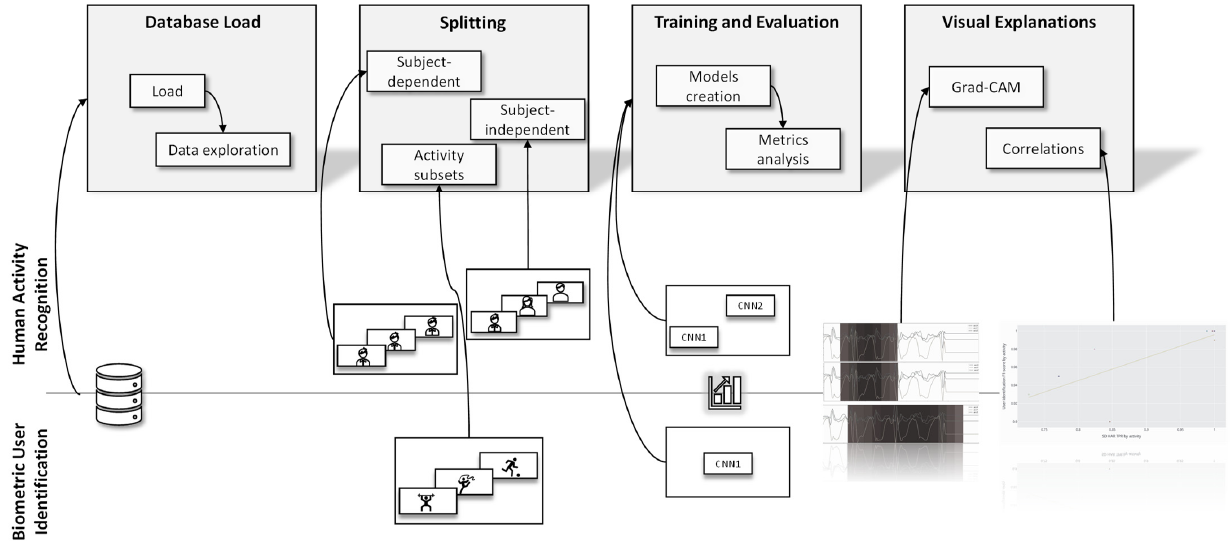
Figure 5. Summary of the framework used for the work. In the top part, we have the processes applied in HAR, in the bottom part, the processes applied in BUI.